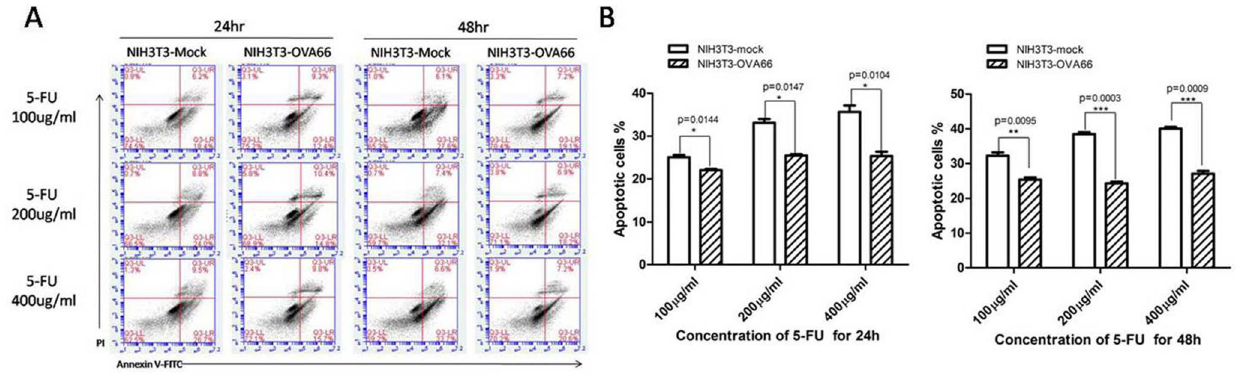
Figure 4. Apoptosis assay. A. FACS analysis of apoptosis using Annexin-V/PI stains detected by BD Accuri C6 flow cytometer. B. Apoptotic cells at 24 h and 48 h after treatment with different concentrations of 5-FU were quantified. The data are represented as mean 6 SEM (n=3), * P # 0.05, ** P # 0.01, *** P # 0.001.